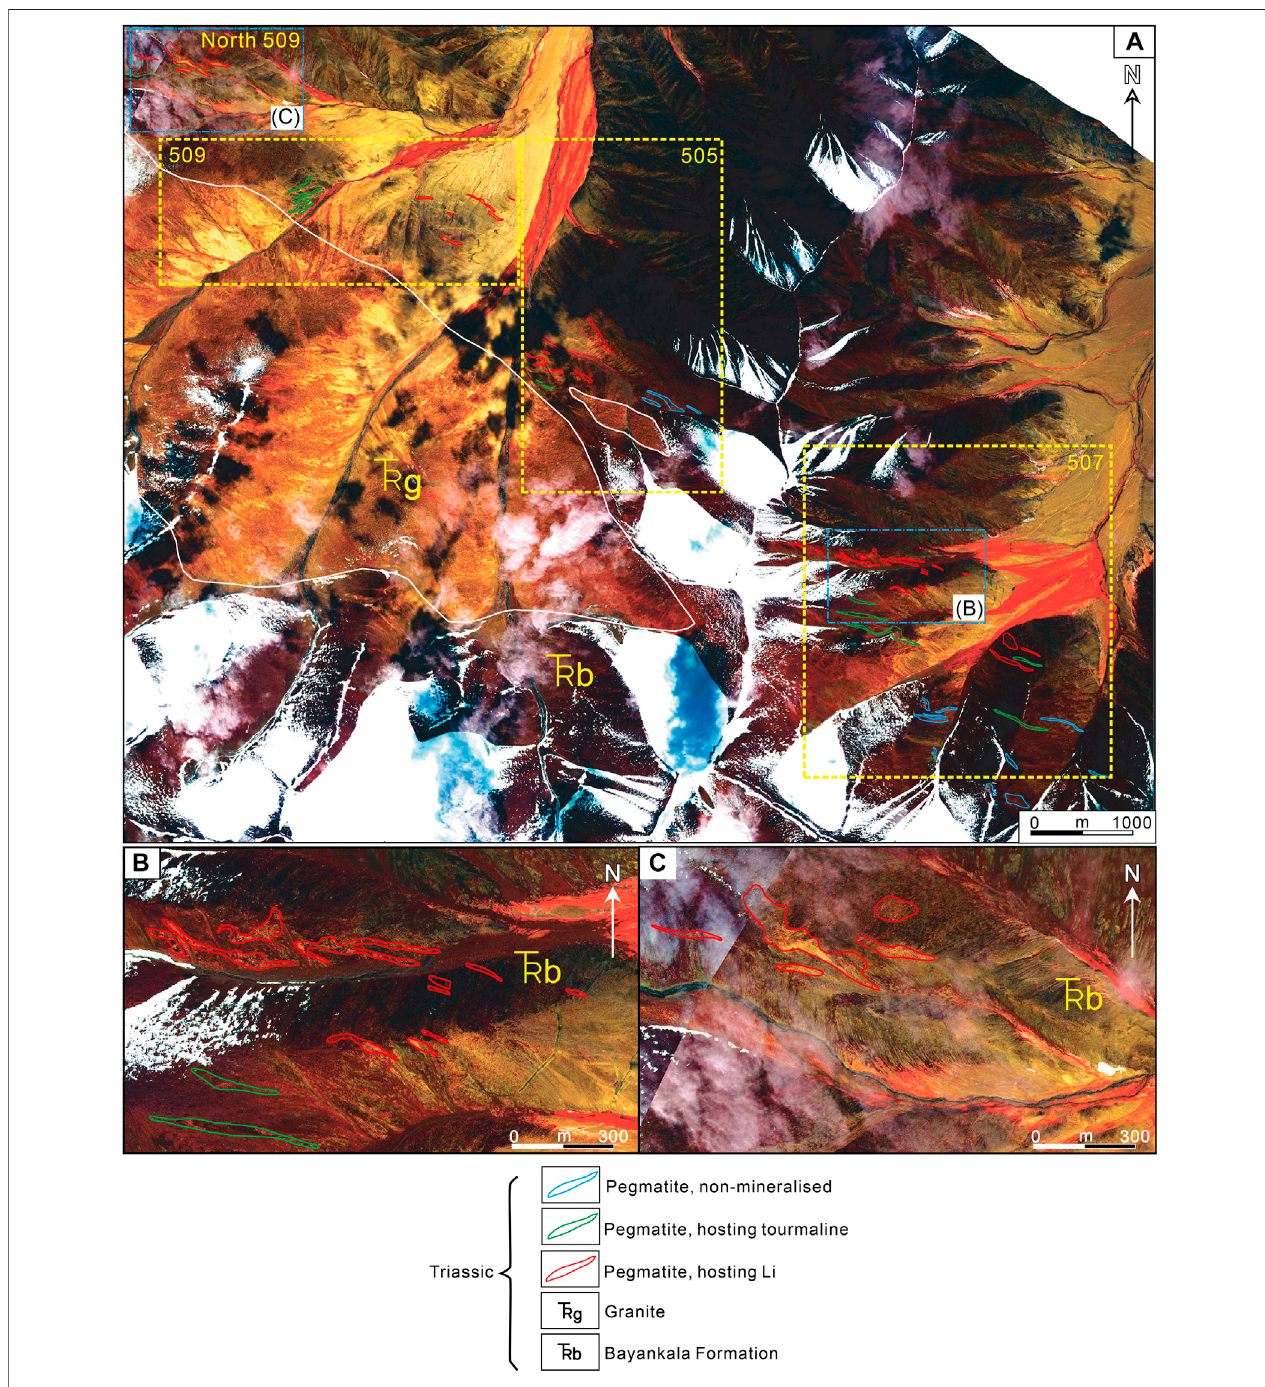
FIGURE 13 | Worldview-3 remote sensing images with an 841-band combination and enhanced processing for the 505, 507 Li deposits and surrounding areas showing: (A) the whole area; (B) the 507 Li-deposit; and (C) the potential area for Li deposits in the North 509 area. Pegmatite veins with widths of at least 1 m appear whiteontheimages and theBayankalaFormation host isredand greyish brownincolour inparts (B,C) .The increased resolutionoftheWorldview-3images resulted in an increase in the recognition of mineralised pegmatite dykes in part 14C .